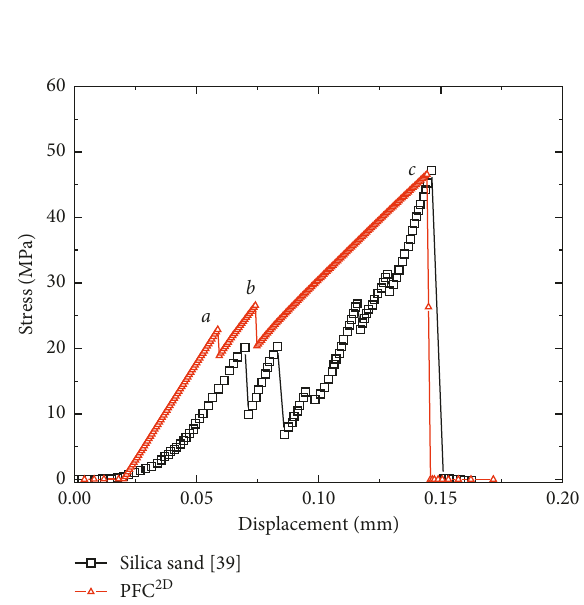
Figure 3: Single sand particle compression